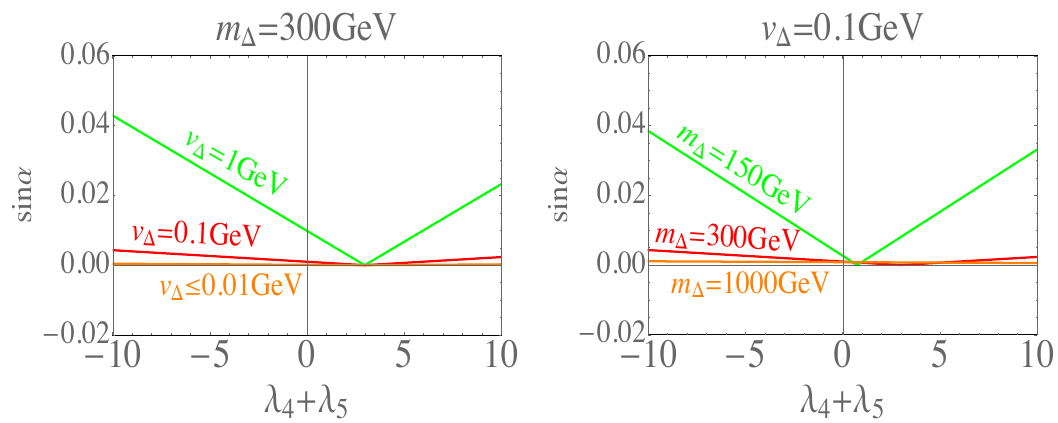
Figure 2 . The dependence of sin (cid:11) on (cid:21) 23 is negligible due to the smallness of v (cid:1) , and (cid:21) 1 (cid:25) m 2 = (2 v 2 ) (cid:25) 0 : 129, such that sin (cid:11) is approximately a function of (cid:21) 45 , m (cid:1) and v (cid:1) . On the left (right) h panel we (cid:12)x m (cid:1) = 300 GeV ( v (cid:1) = 0 : 1 GeV) and plot sin (cid:11) with respect to (cid:21) 45 with di(cid:11)erent v (cid:1) ’s ( m (cid:1) ’s). One observes that sin (cid:11) becomes su(cid:14)ciently small for increasing m (cid:1) and/or decreasing v (cid:1)